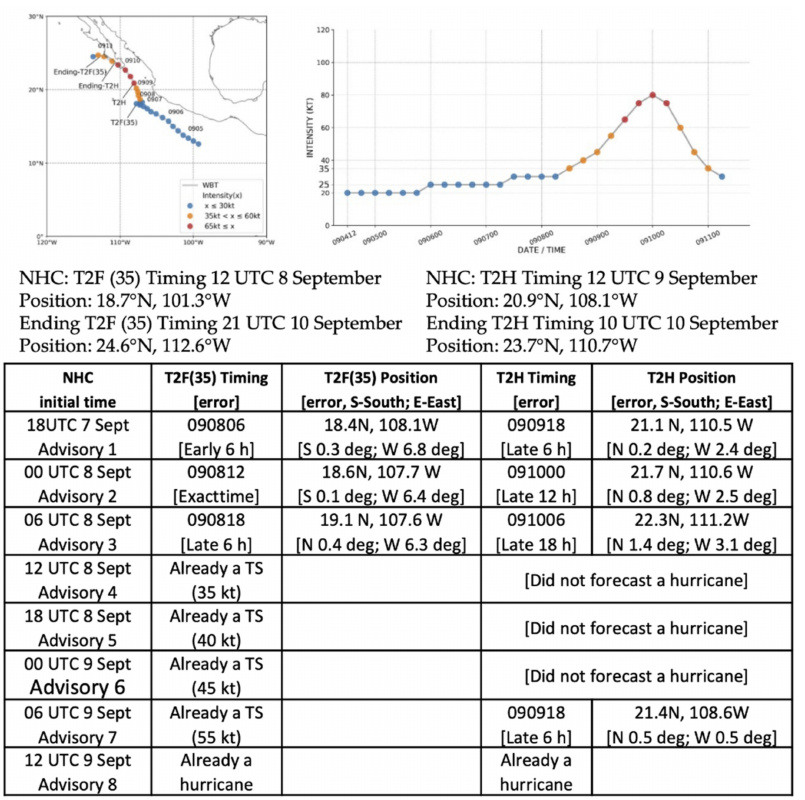
Figure 12. National Hurricane Center (NHC) forecasts of the T2F(35) and the T2H timing and positions based on NHC advisories as in Figure 4 except during